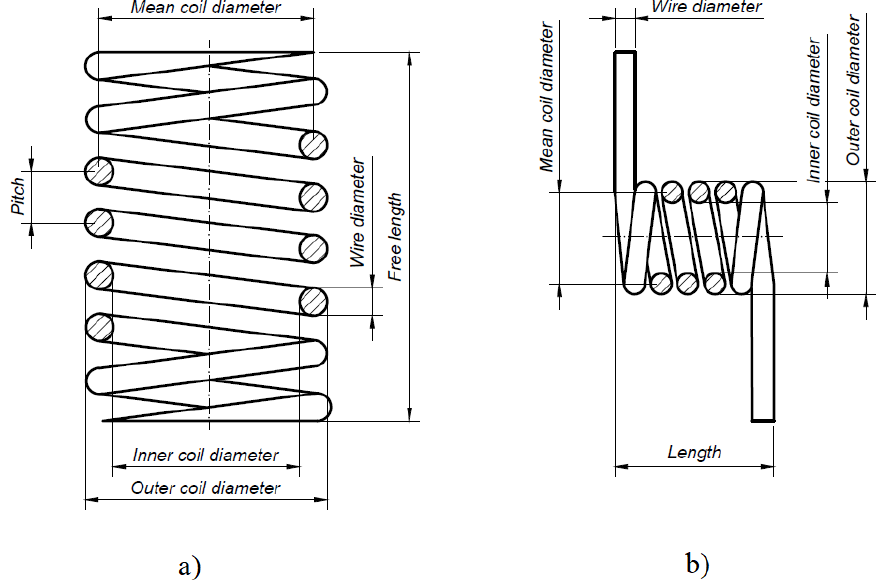
Figure 1. Basic spring geometry. ( a ): Compression spring, ( b ): Torsion spring.